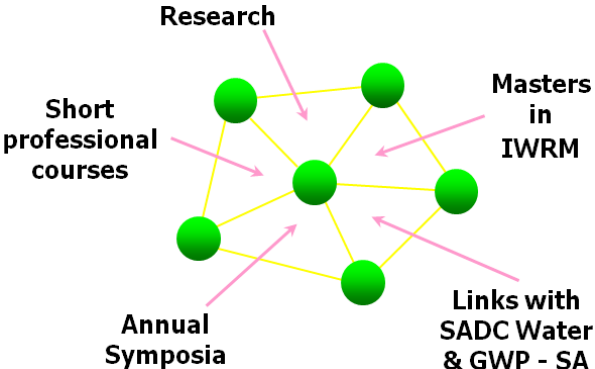
Fig. 1. WaterNet and its mutually reinforcing